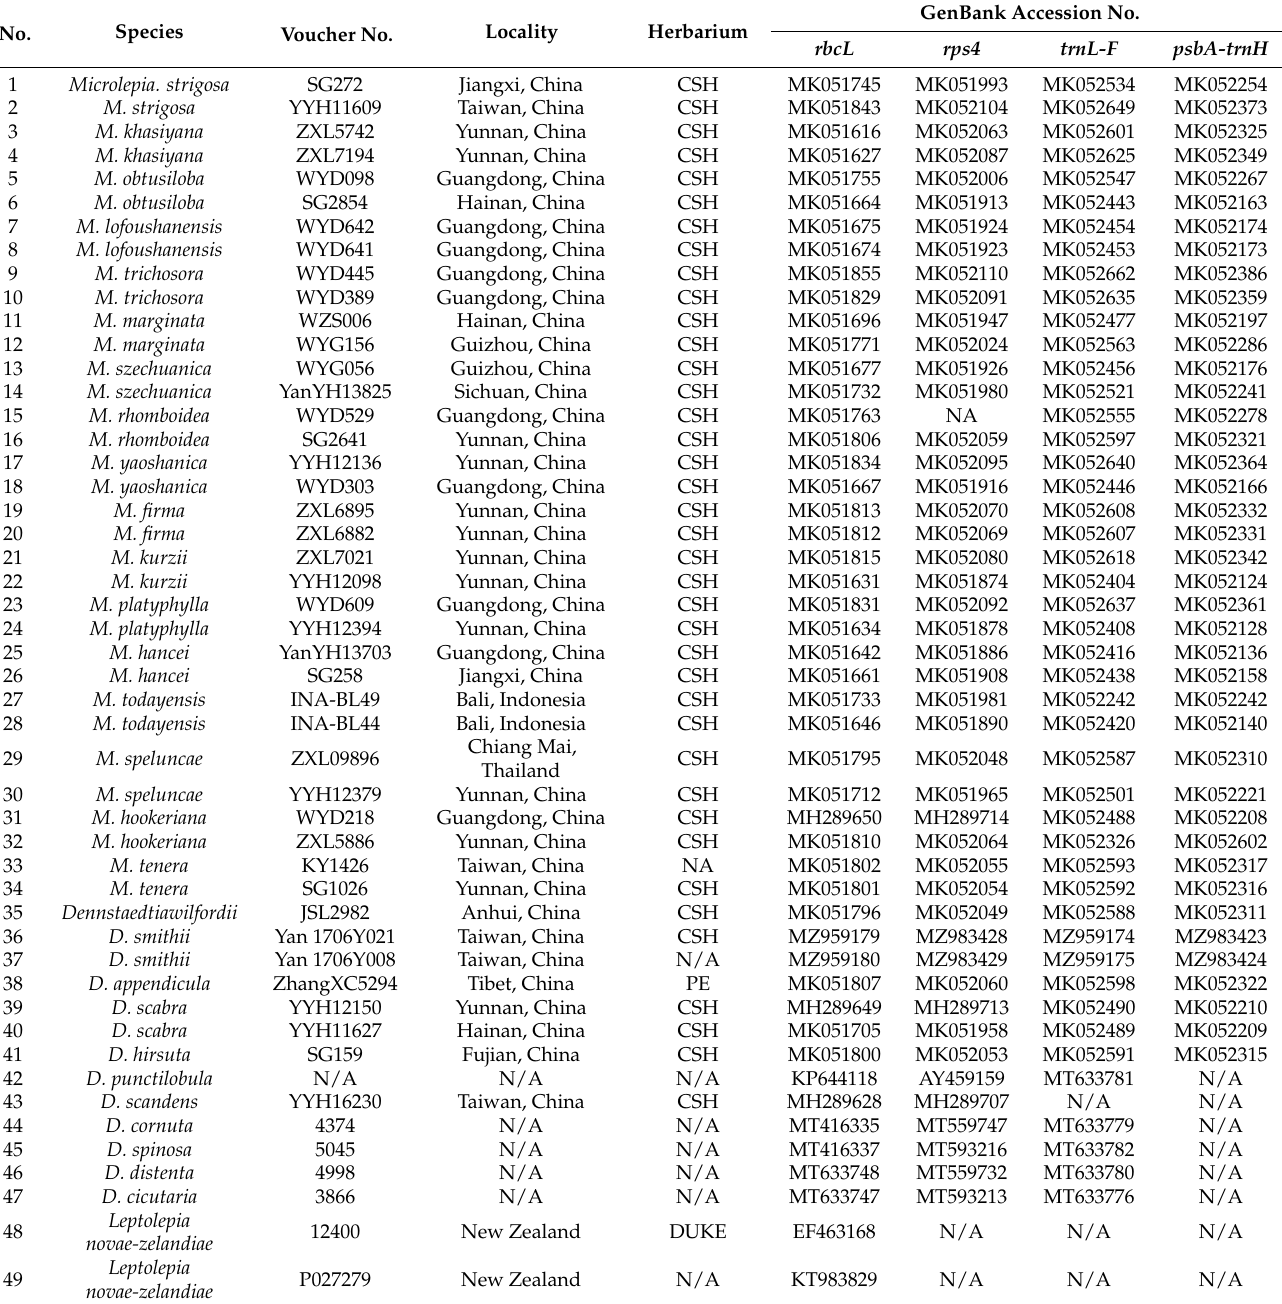
Table 1. List of 54 Specimens information and GenBank